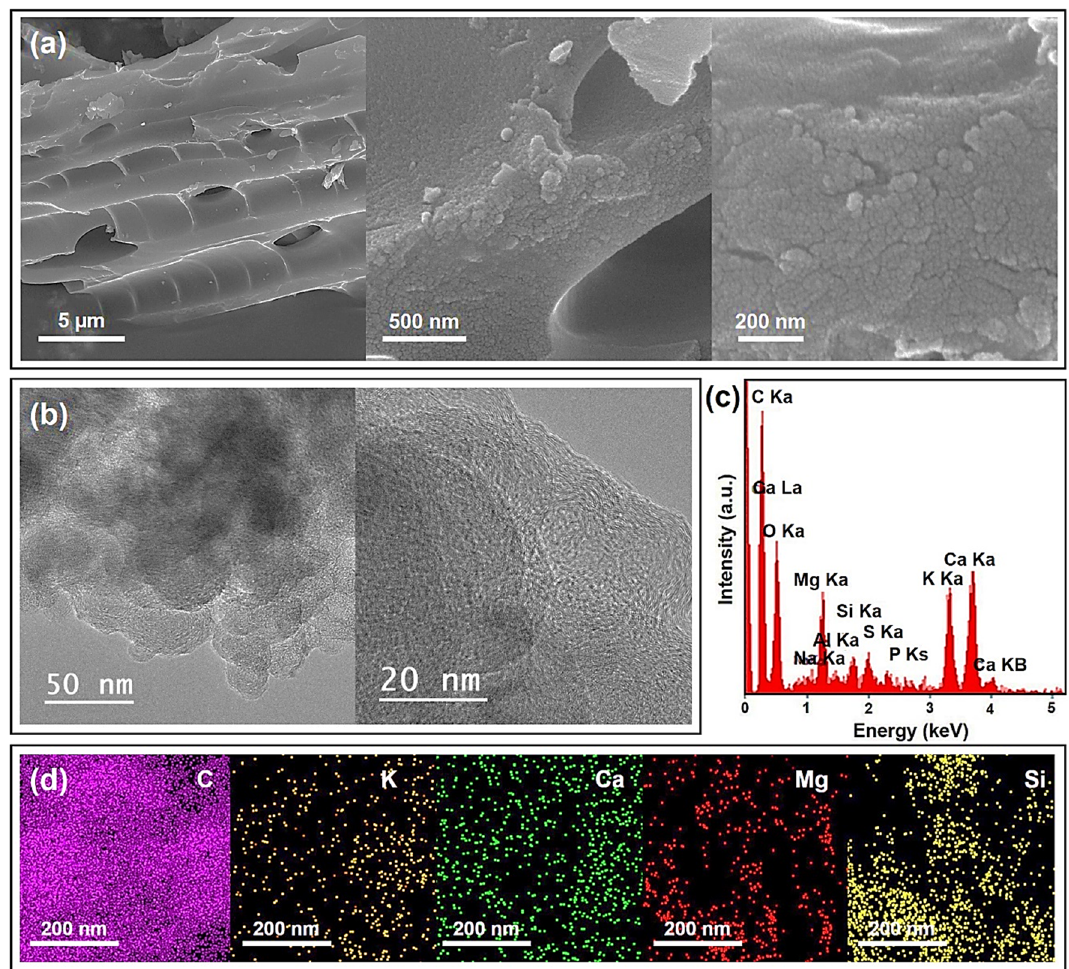
Figure 2. ( a ) FE-SEM, ( b ) TEM and HRTEM images, ( c ) EDX analysis and ( d ) EDX elemental mapping of WA prepared at 850